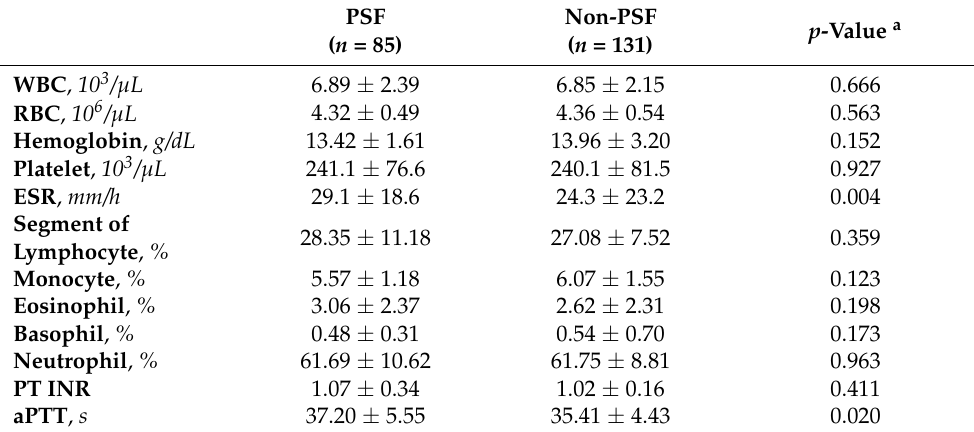
Table 3. Comparison of hematologic parameters between the PSF non-PSF